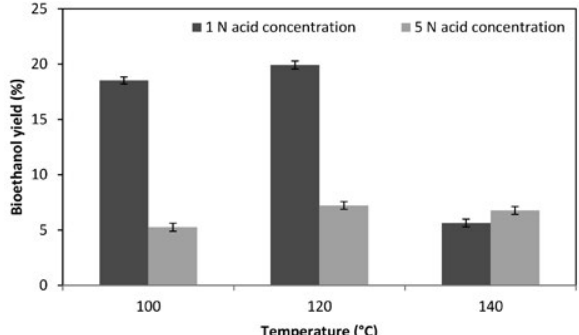
Fig 4. Effect of different acid pre-treatment temperatures on bioeth- anol